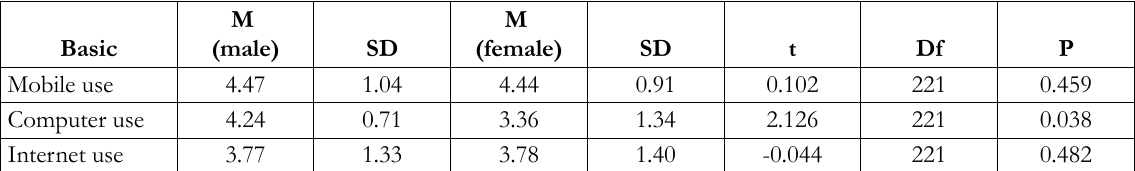
Table 6. The difference in the basic use of digital devices